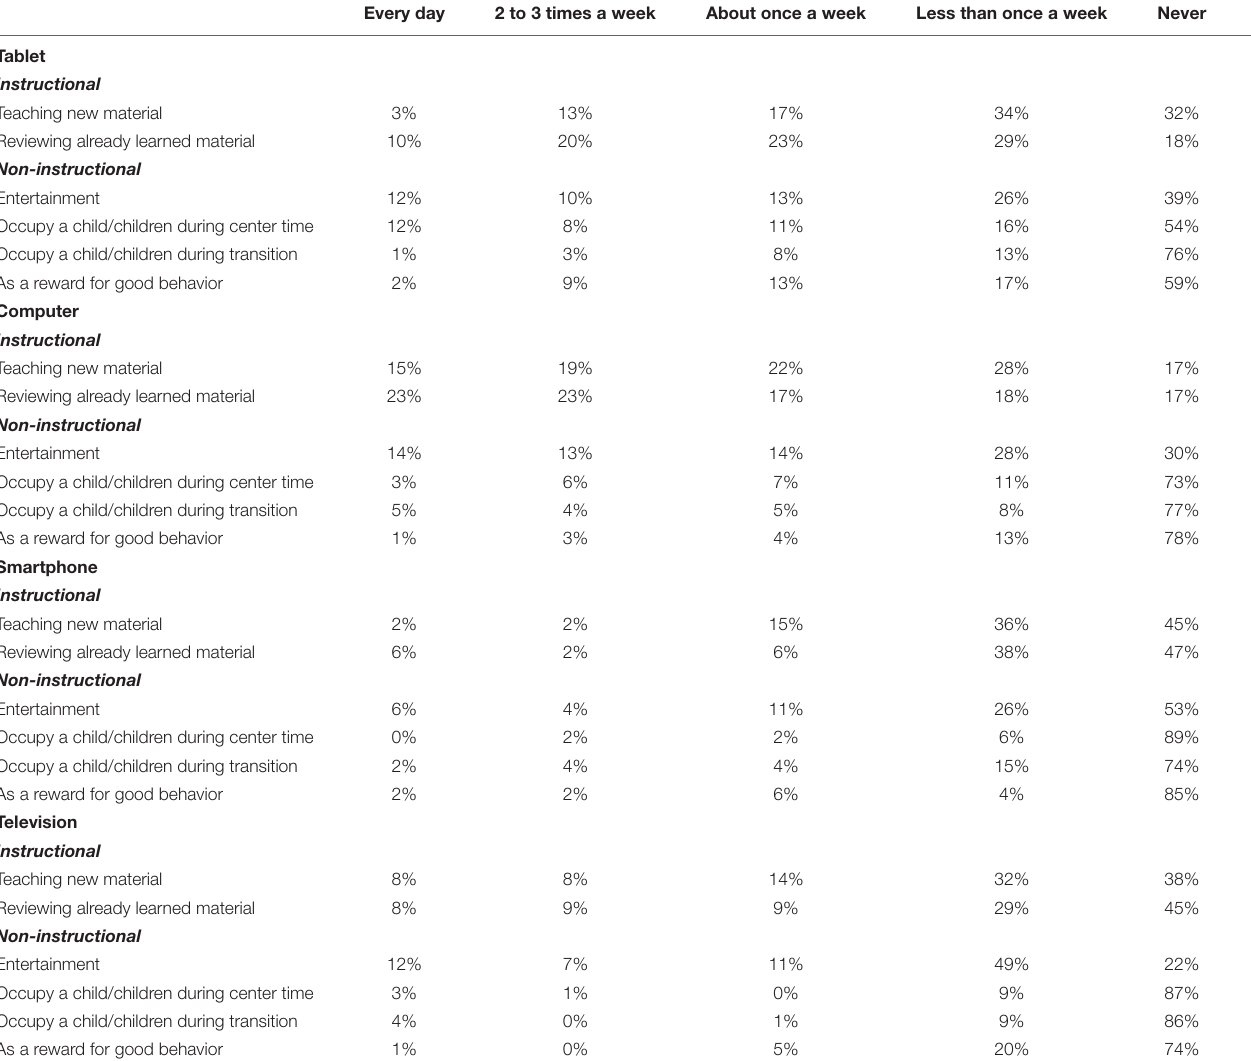
TABLE 2 | Frequencies for purposes of teachers’ reported technology and media use. Every day 2 to 3 times a week About once a